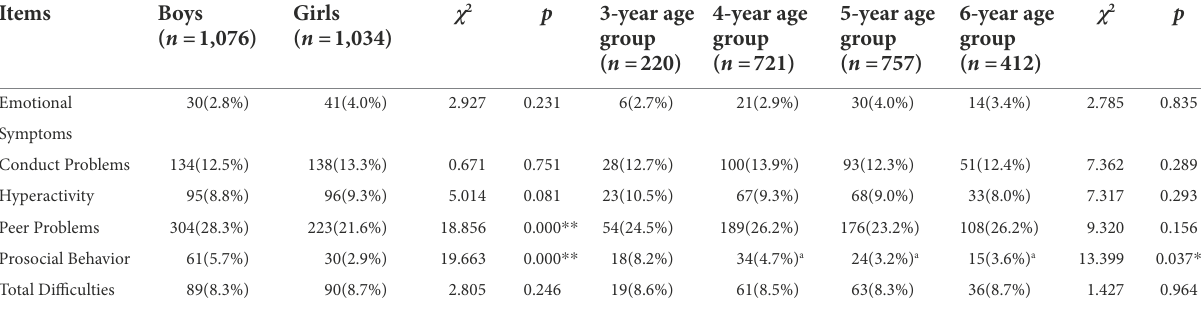
TABLE 2 Comparison of detection rates of emotional and behavioral problems in preschool children by gender and age.